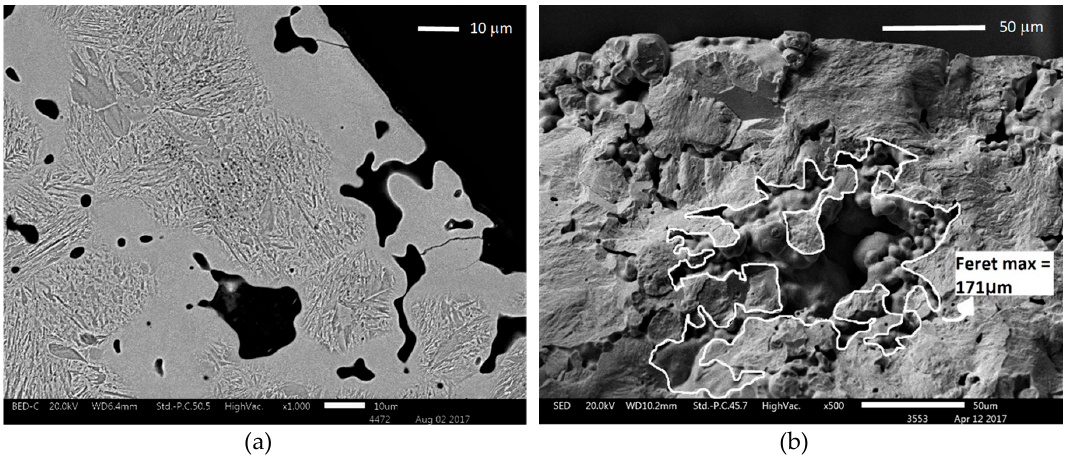
Figure 8. Fractographic inspections of DHP: ( a ) crack path (SEM), ( b ) crack initiation site (SEM).